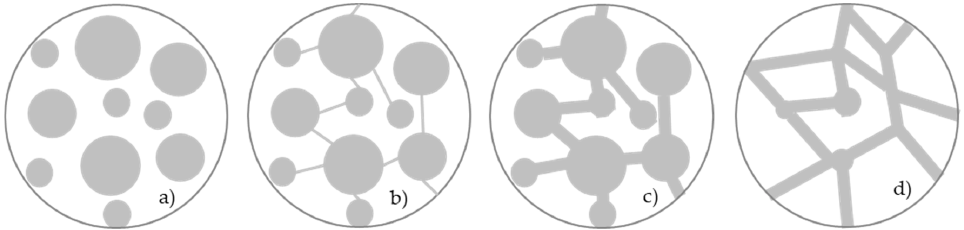
Figure 1. Schematic representation of porosity vs permeability (adapted from [25]): ( a ) high porosity / negligible permeability; ( b ) high porosity / low permeability; ( c ) high porosity / high permeability; porosity/negligible permeability; ( b ) high porosity/low permeability; ( c ) high porosity/high ( d ) high porosity / high permeability; ( d ) high porosity/high permeability .